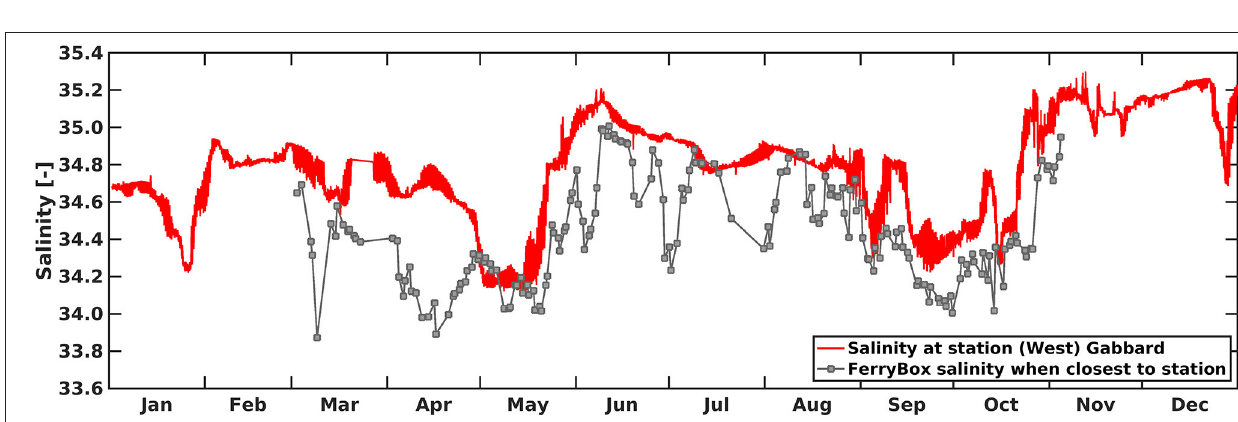
FIGURE 5 | Salinity observations collected on the ferry transect Cuxhaven–Harwich within the period June 1, 2002 ± 40 days. Based on hydrodynamic fields from TELEMAC-2D, each water body was transported either forward or backward in time (maximum travel time 40 days) to estimate its position at the time of the map shown. Gray arrows indicate marine currents, and winds are represented by blue wind barbs.